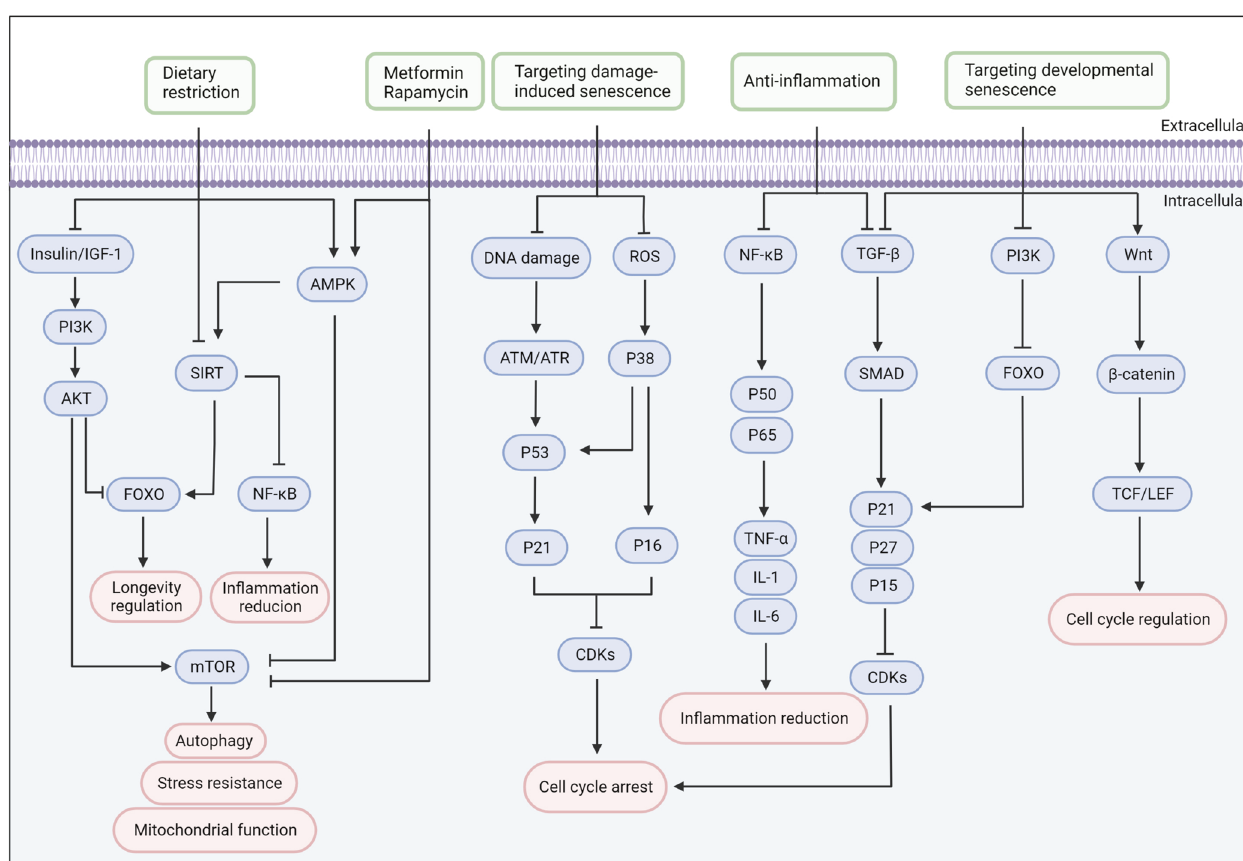
Fig. 3 The target signaling pathways for cellular rejuvenation. Target signaling pathways for cellular rejuvenation are listed according to their biological functions. Many interventions, like dietary restriction and drugs, improve metabolism and extend longevity through nutrient- sensing pathways. In addition, targeting the pathways of damage-induced and developmental senescence can regulate the cell cycle and alleviate age-associated phenotypes. Modulating many in fl ammation pathways also provides an effective route to rejuvenation. IGF-1 insulin- like growth factor 1, PI3K phosphoinositide 3-kinase, AKT protein kinase B, AMPK 5 ’ -AMP-activated protein kinase, NF- κ B nuclear factor- κ B, STAT3 signal transducer and activator of transcription 3, mTOR mammalian target of rapamycin, SIRTs sirtuins, FOXO forkhead homeobox type protein O, ROS reactive oxygen species, TGF- β transforming growth factor- β , CDKs cyclin-dependent kinase. Created with